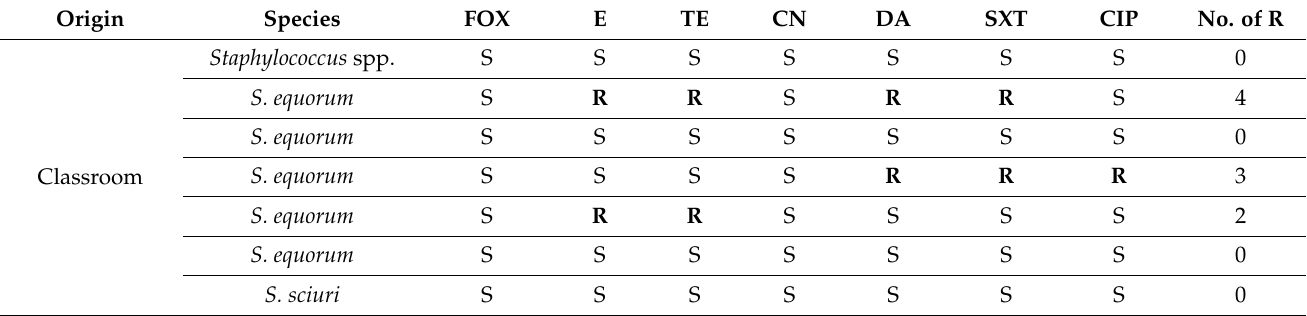
Table 5. Summary of Staphylococcus species and antimicrobial resistance * detected in the examined premises.